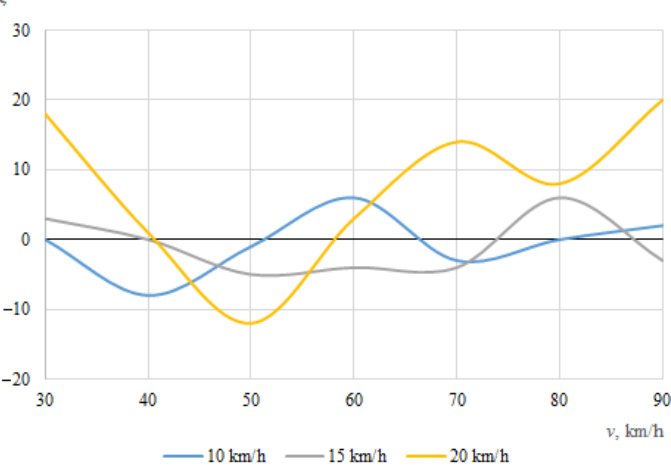
Figure 16. Bicycle throwing angle (impact angle 60 ◦ ).